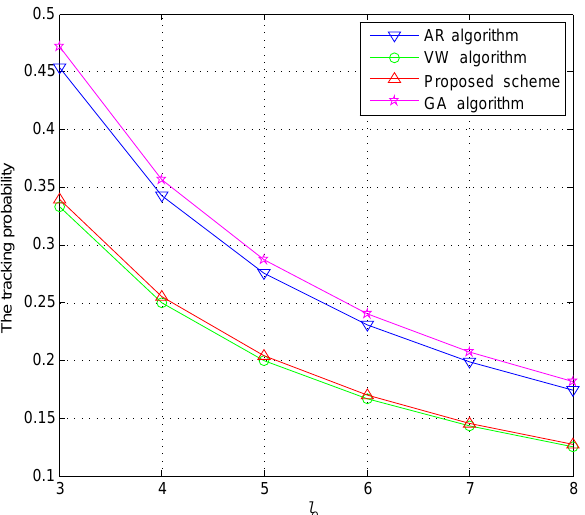
Figure 7. The tracking probability (cid:101) comparison with different query requirement l 0 . ( k 0 = 10, λ 0 = 2).